Question: Briefly state, in one sentence, what is plotted here.
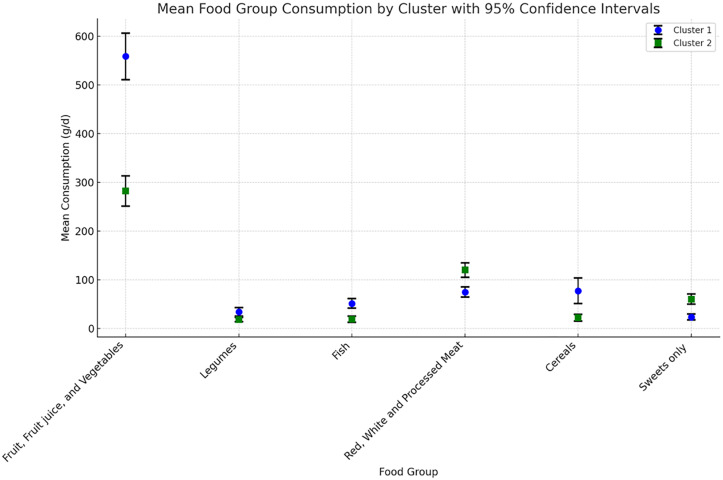
Answer: long description. Comparative analysis of dietary patterns in cluster 1 and cluster 2. The figure displays the average intake of 6 food groups (fruit, fruit juice, and vegetables; legumes; fish; red, white, and processed meat; cereals; and sweets) based on the 2-cluster solution identified using k-means clustering. Error bars represent 95% confidence intervals for the mean values. Non-overlapping intervals highlight distinct dietary patterns between clusters, supporting the validity of the 2-cluster model.